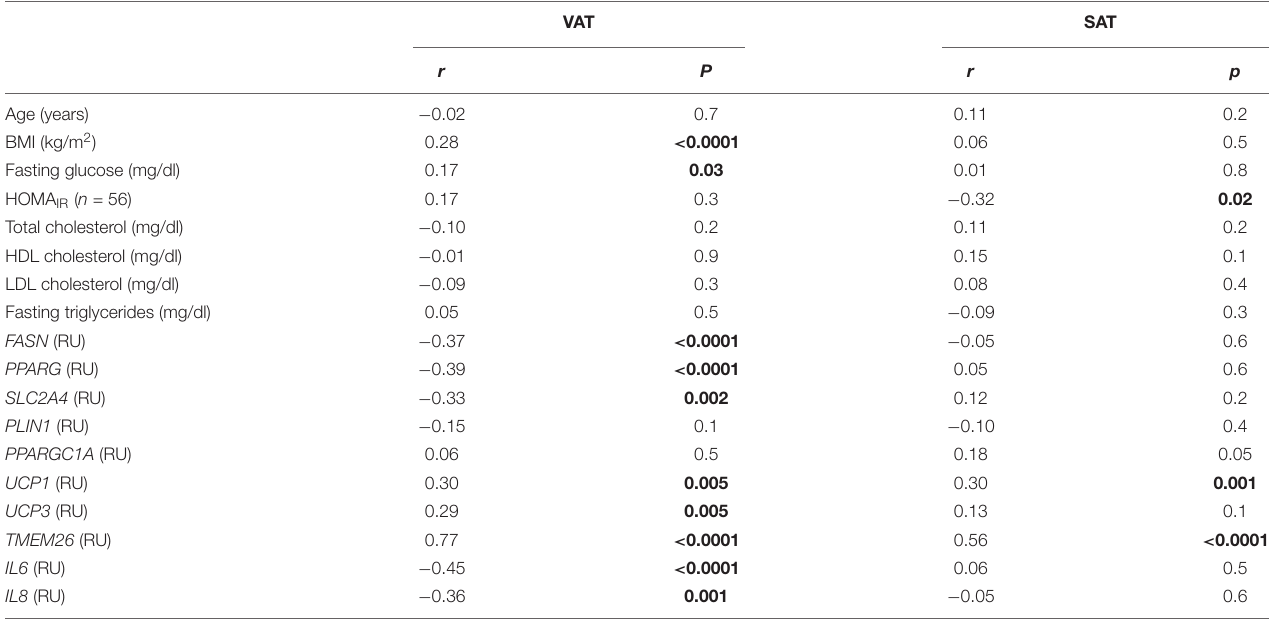
TABLE 3 | Correlation between NRG4 gene expression and anthropometric and clinical characteristics and selected gene expression in SAT ( n = 176) and VAT ( n = 155) from cohort 1. VAT